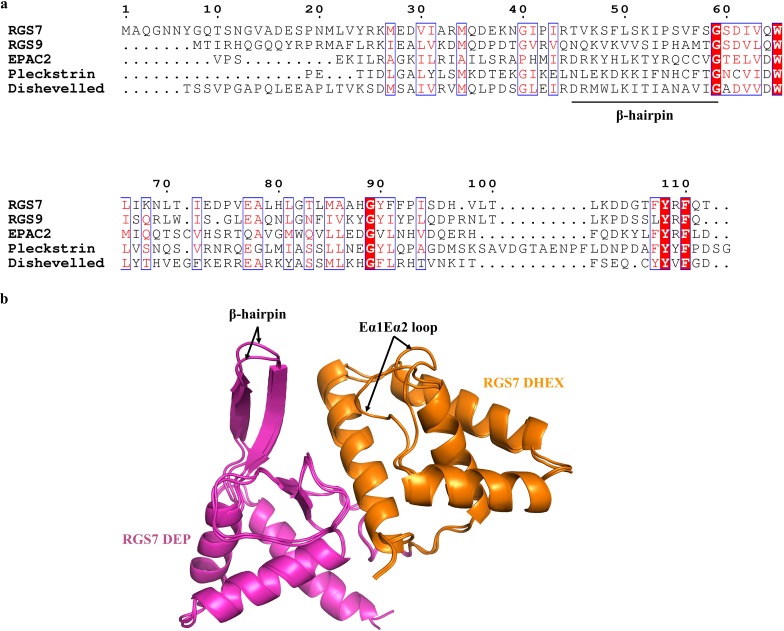
Homology of the DEP domains and loop flexibility in the DEP-DHEX domain of RGS7.(a) Multiple sequence alignments of the DEP domain containing proteins. The β-hairpin shows no sequence conservation. The DEP domain sequences are taken from the structures of RGS7, RGS9 (PDB entry 2pbi), EPAC (PDB entry 2byv), pleckstrin (PDB entry 1w4m), and Dvl (PDB entry 1fsh). This Figure was generated with ESPript 3.0. (b) Comparison of the loop flexibilities of the DEP-DHEX domains of RGS7. Superposition of the two molecules in the asymmetric unit of the RGS7-Gβ5 dimer shows the loop variability in the β-hairpin and the Eα1Eα2 loop is indicated by black arrows. The DEP and DHEX domains are colored in pink and orange, respectively.